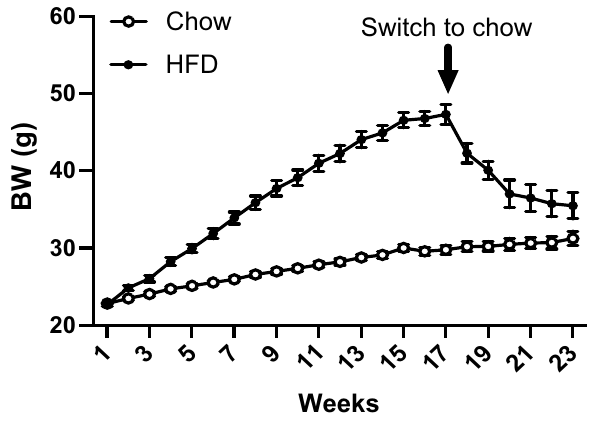
Figure 1. Time course of the study—we used in total 47 mice Data are mean ±